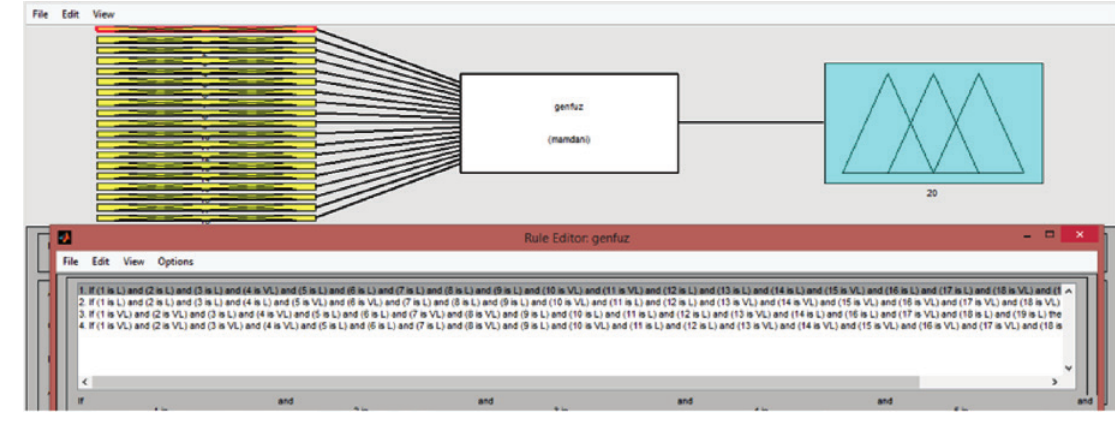
Figure 5: Fuzzy Window of DRD Data.